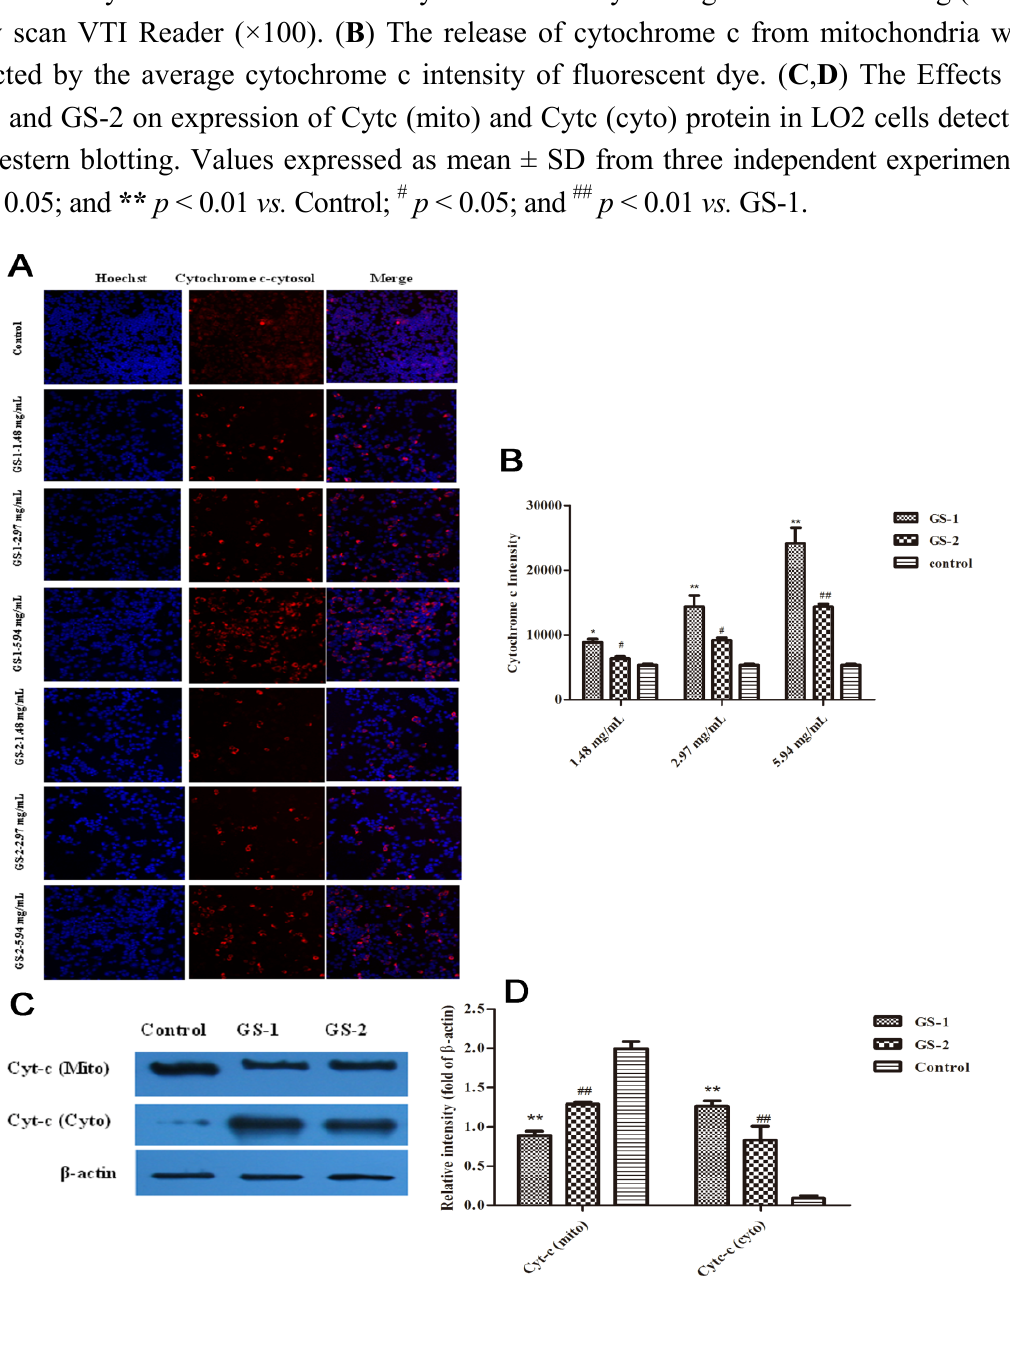
Figure 4. Effects of LO2 cells treated with GS-1 and GS-2 on the release of cytochrome